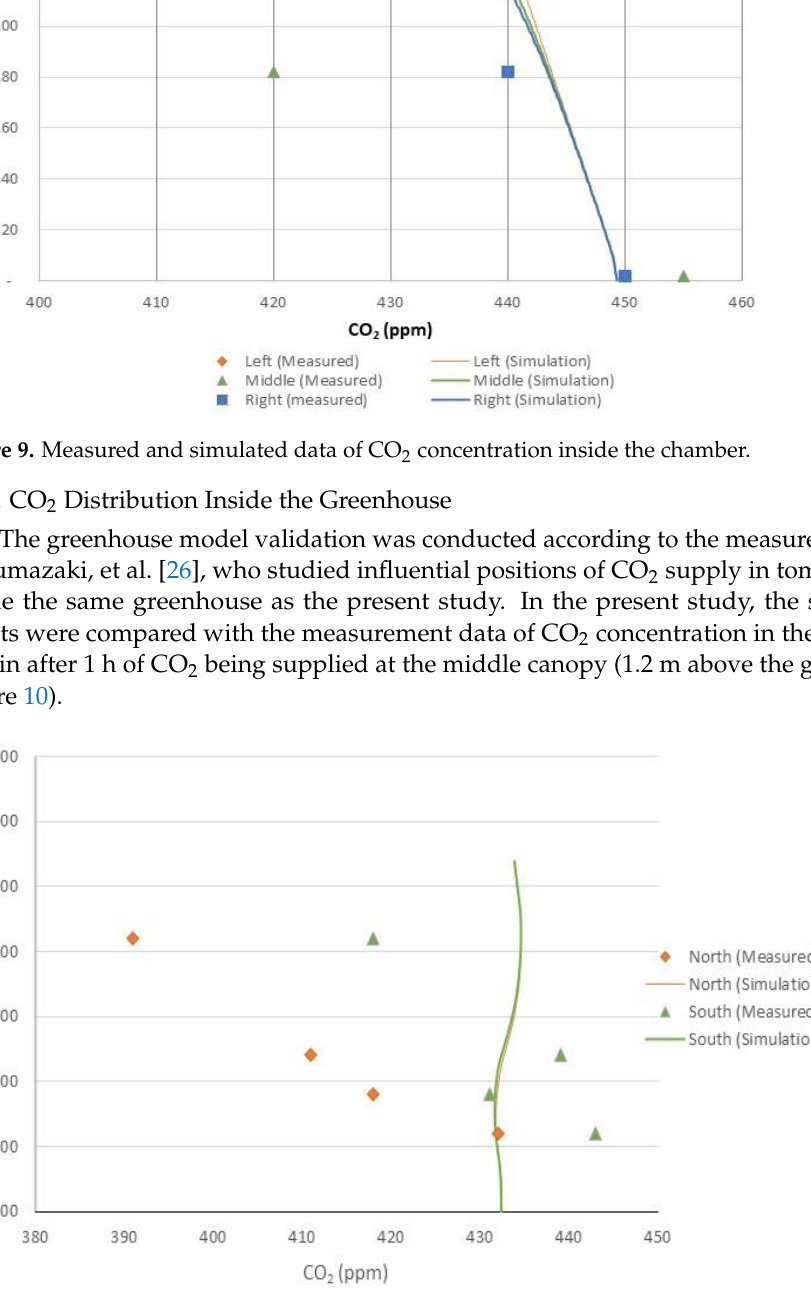
Figure 8. The CO 2 distribution inside the chamber: The values are the measured data of the CO 2 concentration.